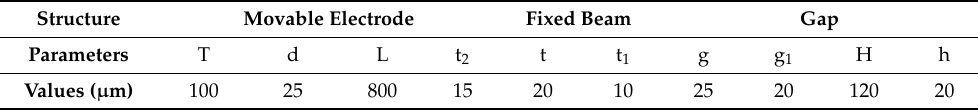
Table 1. The main structure parameters of three-axis inertial switch.